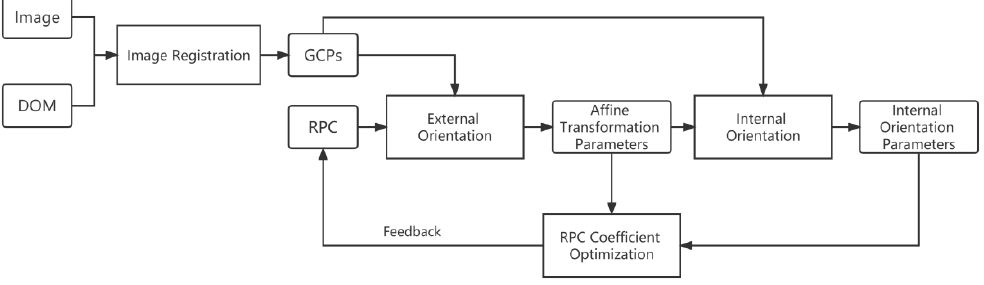
Figure 4. Improved geometric accuracy model.